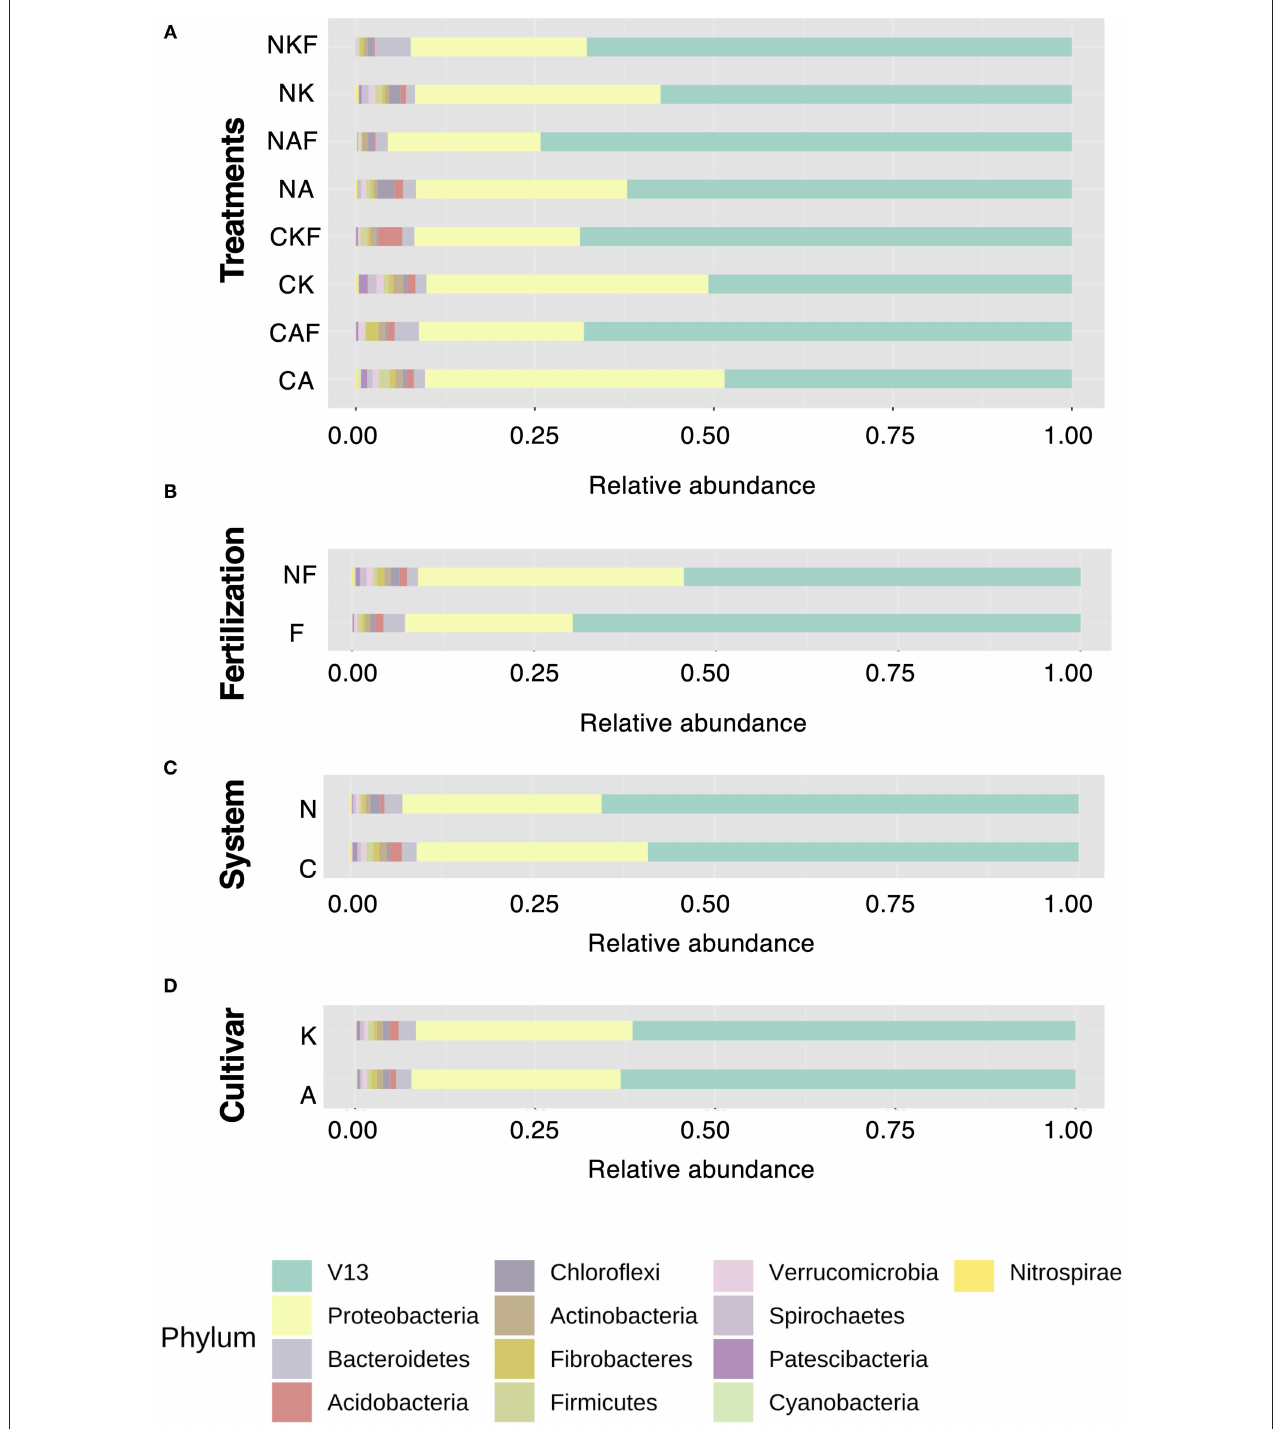
FIGURE 3 | Relative abundance of dominant phyla (A) across the samples, (B) fertilization, (C) farming systems, and (D) rice cultivars. (A) NKF, Koshihikari grown in nature farming soil treated with chemical fertilizer; NK, Koshihikari grown in nature farming soil without chemical fertilizer; NAF, Asahi grown in nature farming soil treated with chemical fertilizer; NA, Asahi grown in nature farming soil without chemical fertilizer; CKF, Koshihikari grown in conventional farming soil treated with chemical fertilizer; CK, Koshihikari grown in conventional farming soil without chemical fertilizer; CAF, Asahi grown in conventional farming soil treated with chemical fertilizer; and CA, Asahi grown in conventional farming soil without chemical fertilizer. (B) NF, no application of chemical fertilizers; F, application of chemical fertilizer. (C) N, Nature farming soil; C, conventional farming soil. (D) K, Koshihikari cultivar; A, Asahi cultivar. V13 refer to taxonomy labels which not assigned or other category cannot be projected to lower